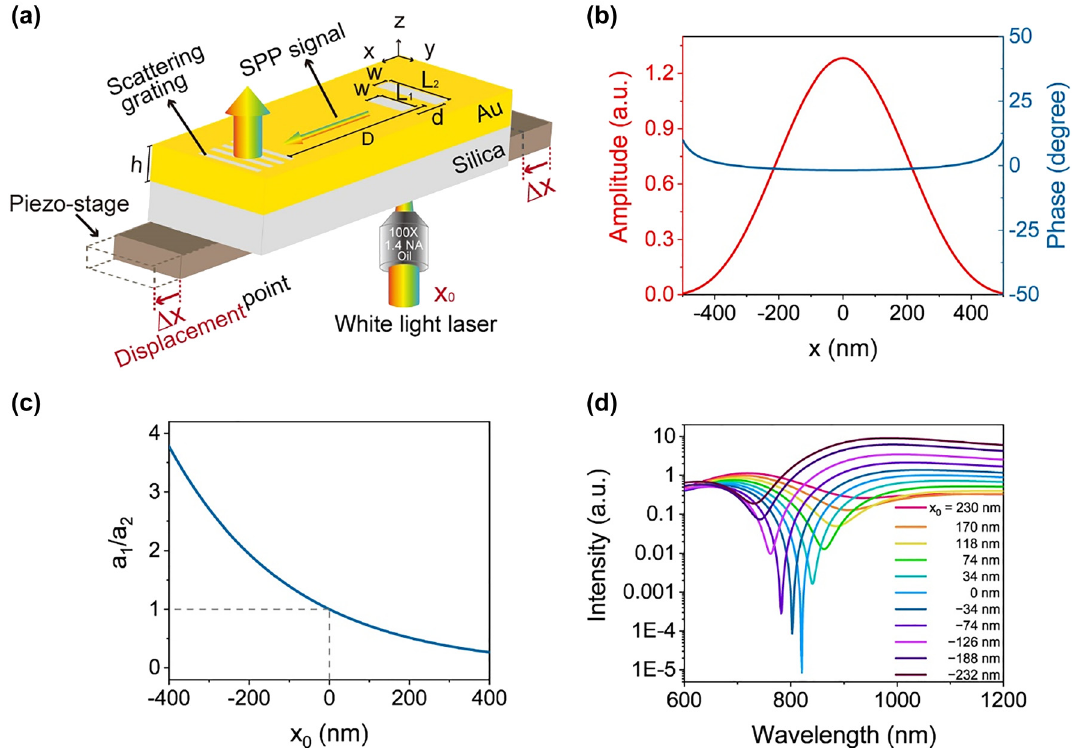
Figure 1: Working principles of the nanoscale displacement sensor. (a) Schematic of the nanoscale displacement sensor. (b) Calculated amplitude and phase distribution of a tightly focused light beam at λ = 815 nm. (c) Calculated a / a 1 2 versus x 0 for a tightly focused lightbeam at γ γ 1 , and 2 are set to be 0.2, 0.4, and 0.5, respectively. The resonant wavelengths of two antennas are set to be 889 and 727 nm,